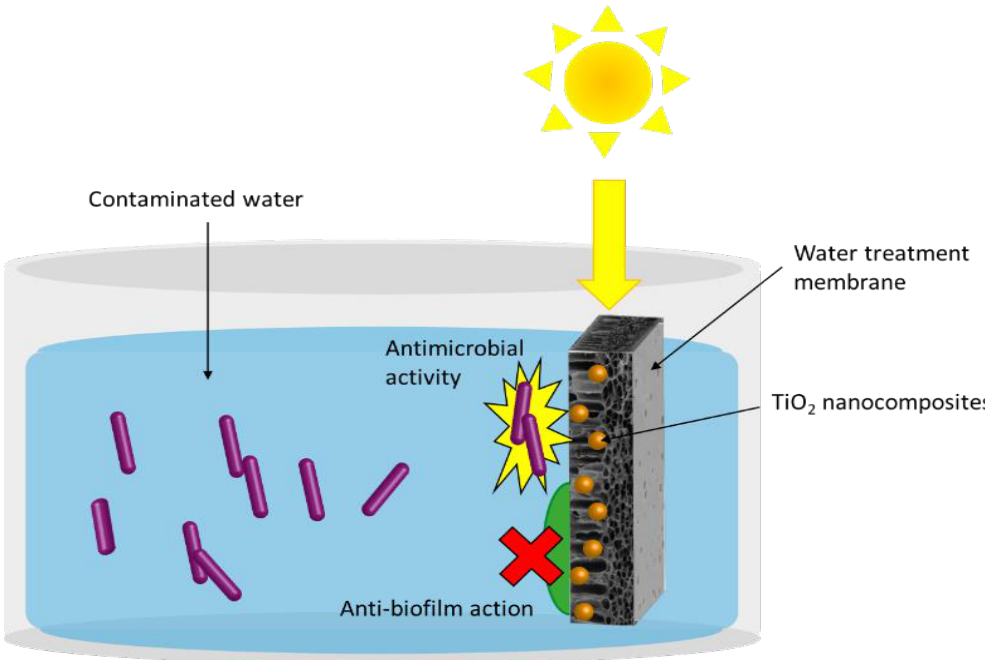
Figure 10. General scheme of TiO 2 NPs-based nanocomposite application for water disinfection, that highlights the ability to prevent biofilm formation at the surface of the substrate, such as a membrane, and the antibacterial activity against water pathogens driven by photocatalysis.